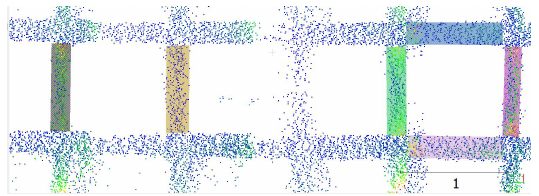
Figure 20. Extraction of several rectangles (successively colored in violet, green, blue, orange, pink and black) from the SR4500 point cloud that correspond to the marking Colour Width (cm) × length (cm) violet 16 × 81 green 20 × 81 blue 21 × 87 orange 21 × 79 pink 20 × 85 black 18 × 79 Table 2. Measured size of marking extracted from the local planes represented in colours on figure 20 With this methodology, the precision of marking sizes is around 2 cm, which corresponds to the precisions of the grid. Since the data were taken at low speed, under a high sun illumination, and without specific calibration, these results are